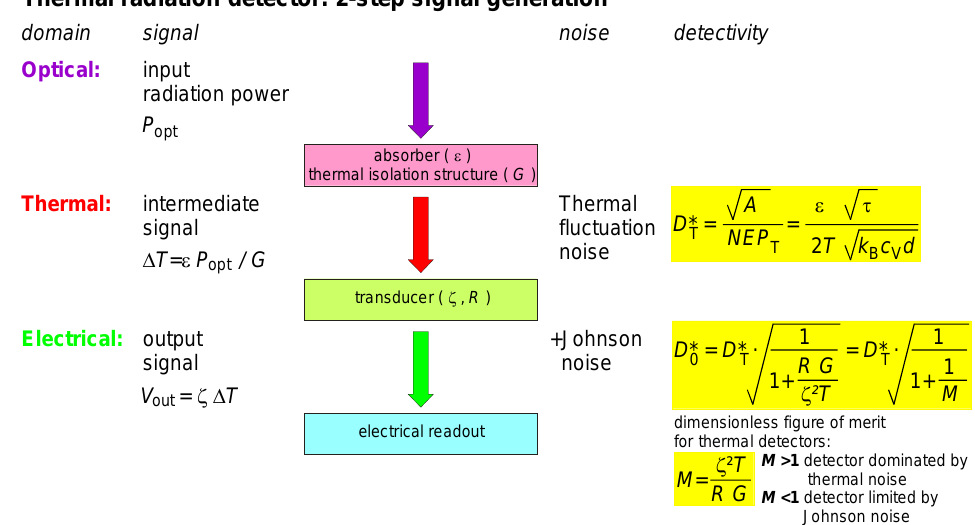
figure of merit for thermal detectors: